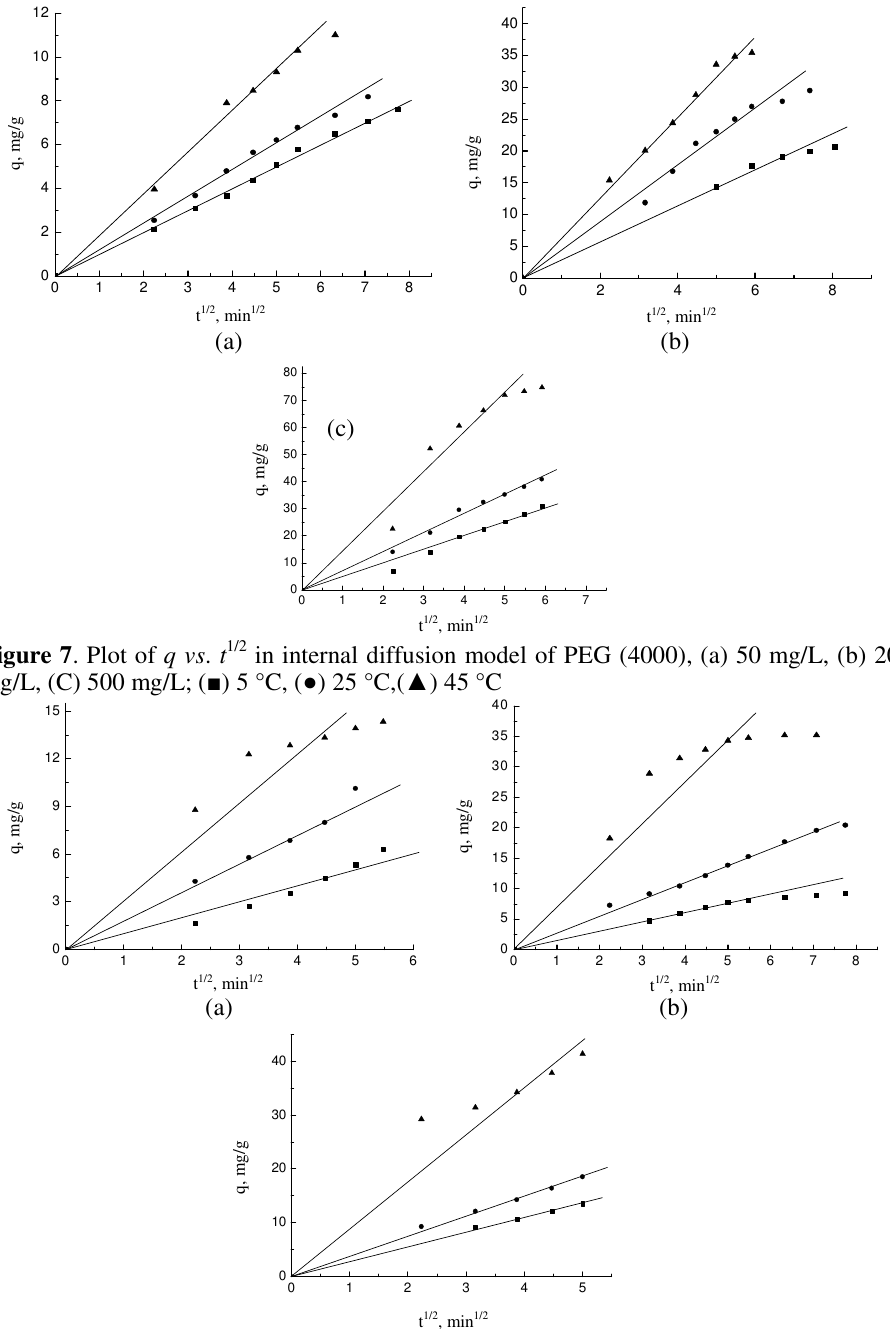
Figure 8. Plot of q vs . t 1/2 in internal diffusion model of PEG (10000). (a) 50 mg/L, (b) 200 mg/L, (C) 500 mg/L; ( ■ ) 5 °C,( ● ) 25 °C,( ▲ ) 45